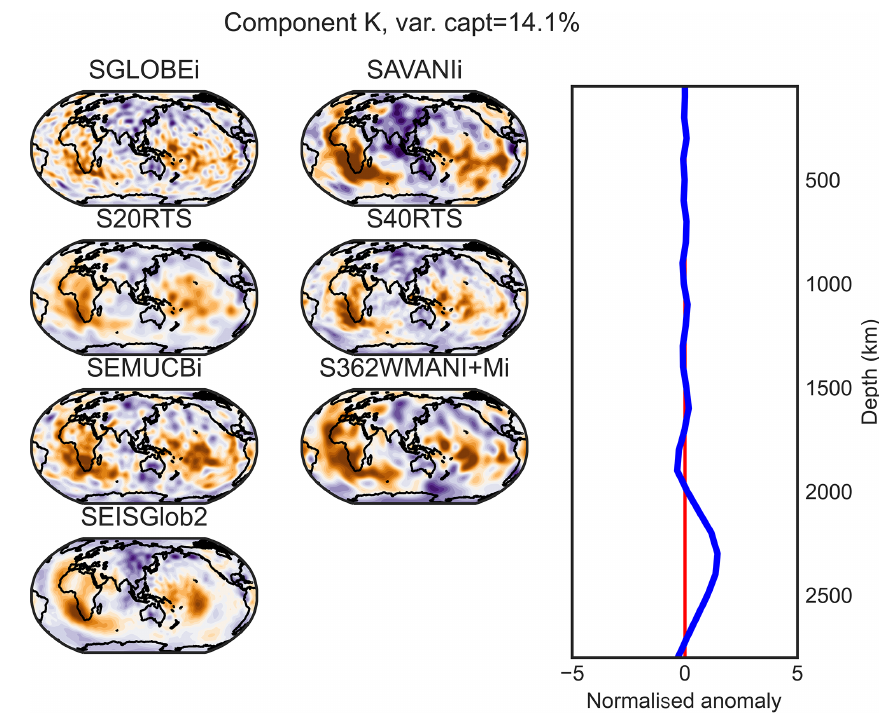
Figure D10. PC K (maximum at 2300km of depth) of the combined analysis of the isotropic parts of the